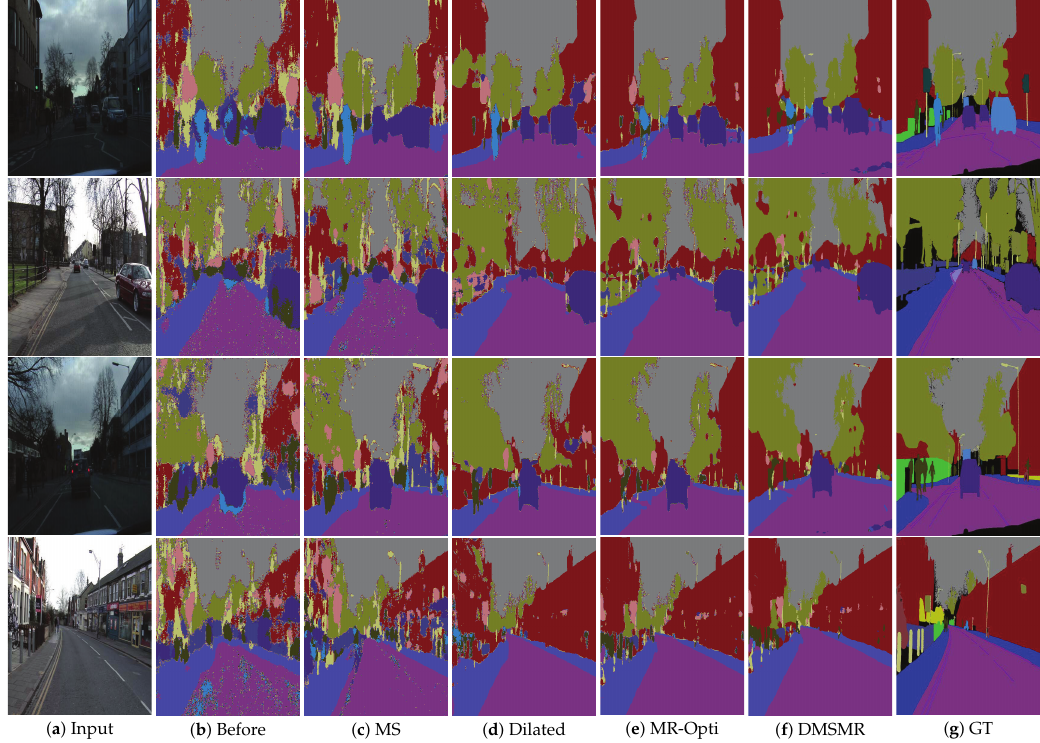
Figure 4. Semantic segmentation results on CamVid images. DMSMR : Semantic segmentation result predicted by dual multi-scale manifold ranking network ( DMSMR ). GT : Ground